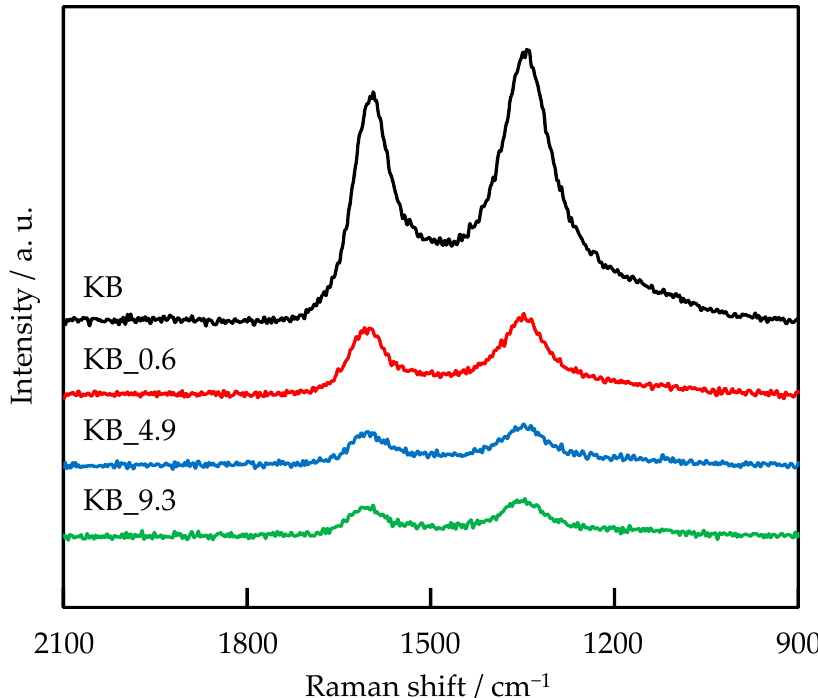
Figure 5. Raman spectra of KB, KB_0.6, KB_4.9, and KB_9.3.